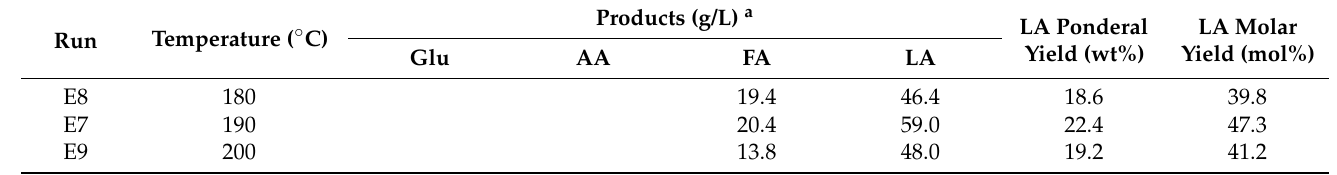
Table 3. Hydrolysis experiments on wet E cardoon sample, with different temperatures. Experimental conditions: reaction time = 20 min, sub/cat = 2.0 mol/mol, biomass loading = 20 wt% (on dry basis), HCl as catalyst (1.4 wt%), MW heating. Products (g/L) Run Temperature ( ◦ C)